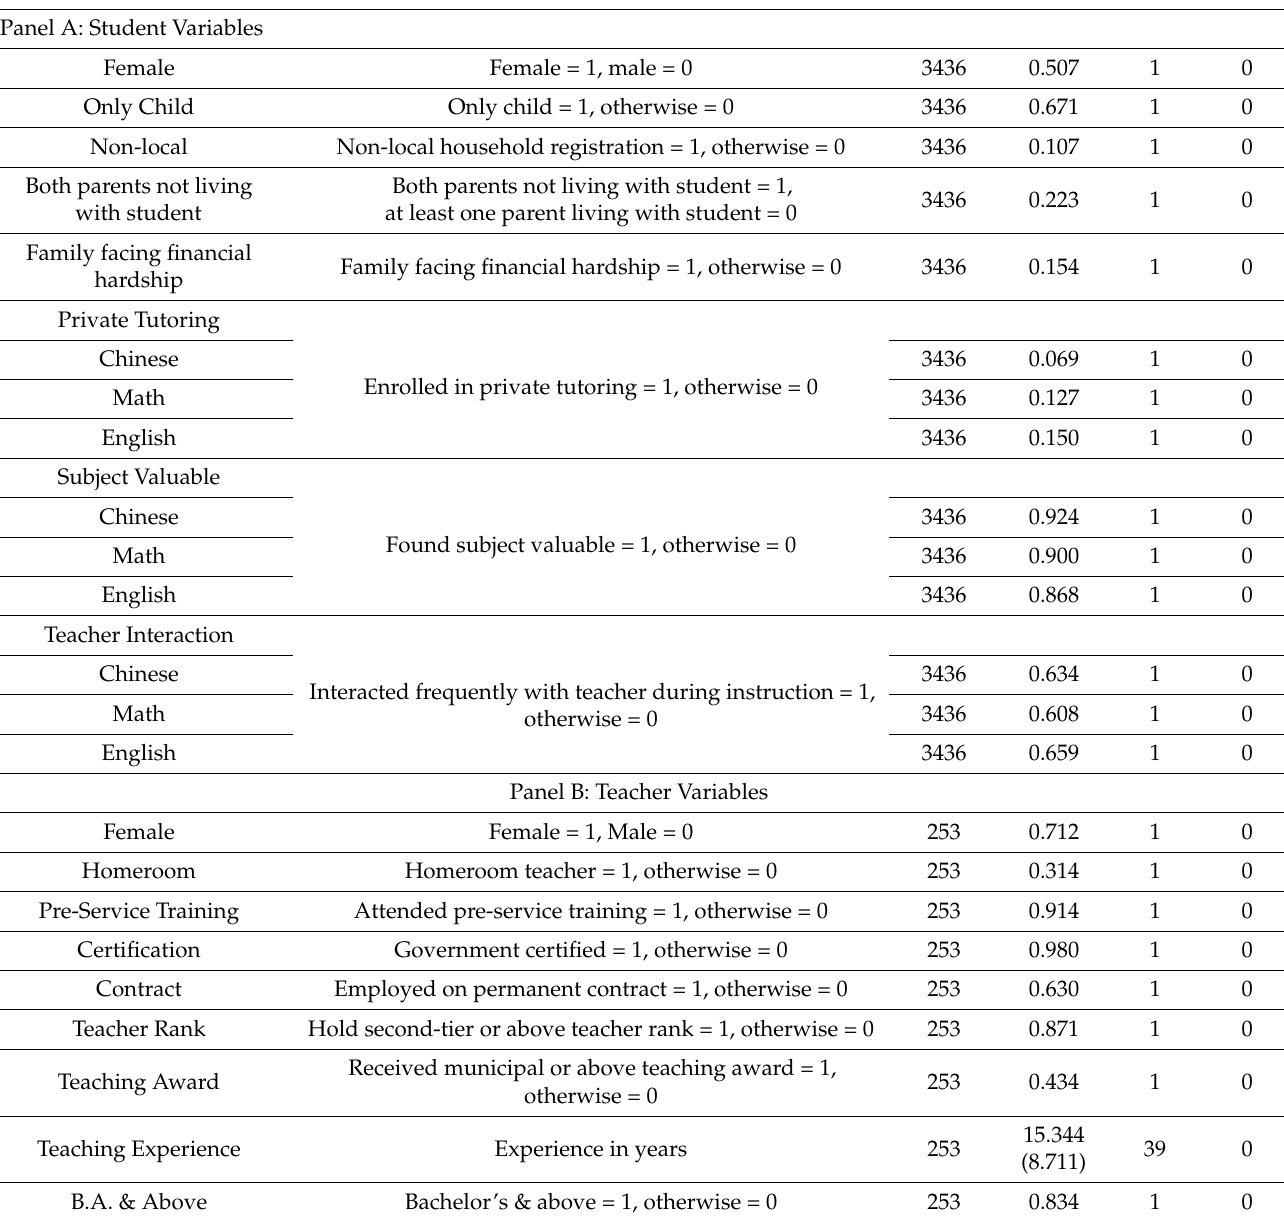
Table 3. Descriptive statistics of study participants (N =